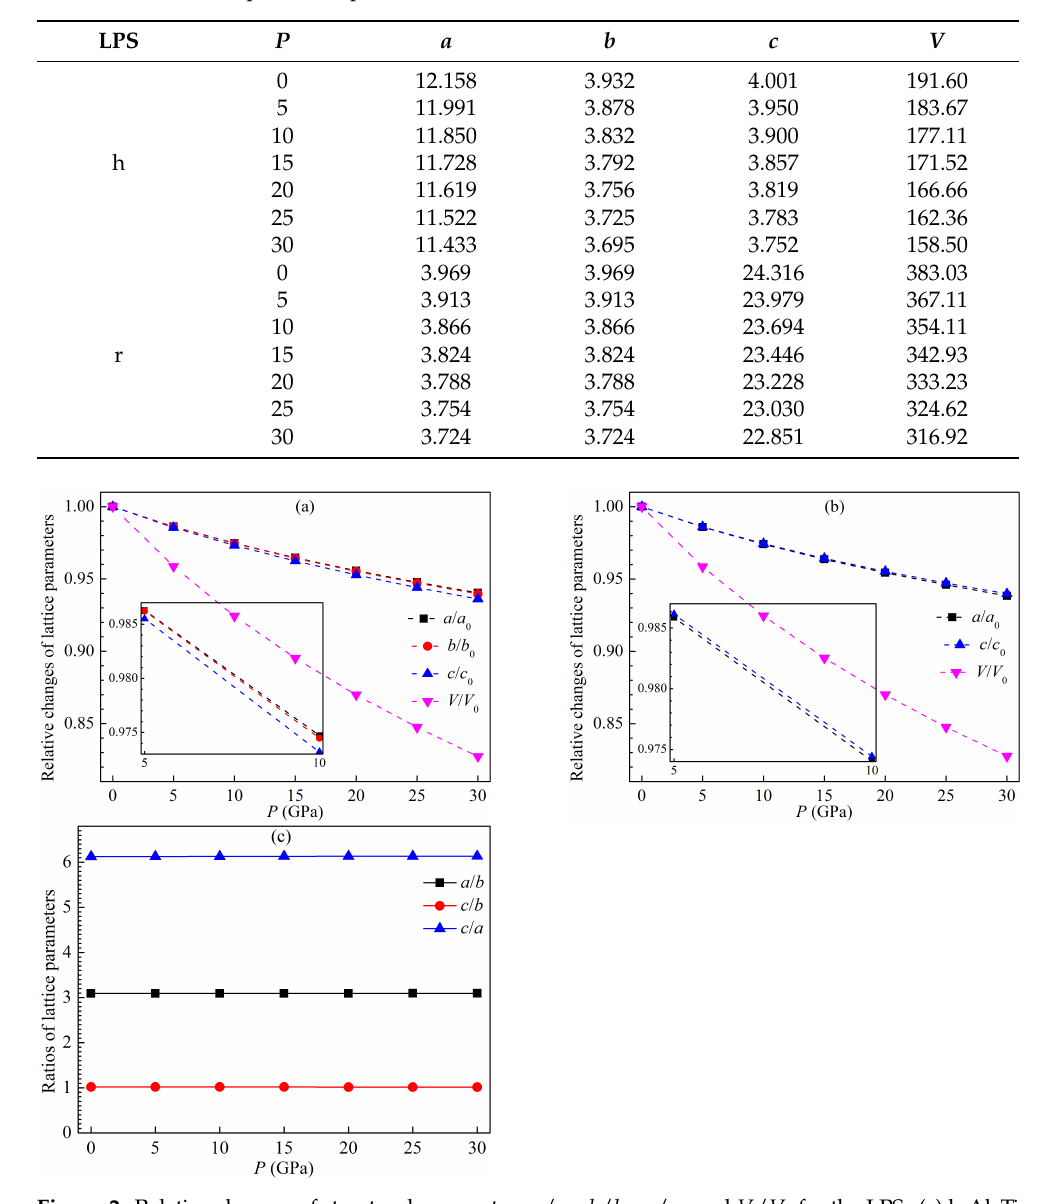
Figure 2. Relative changes of structural parameters a / a 0 , b / b 0 , c / c 0 and V / V 0 for the LPSs ( a ) h-Al 2 Ti and ( b ) r-Al 2 Ti at 0 K, and ( c ) the a / b and c / b of the h LPS and the c / a of the r one as a function of